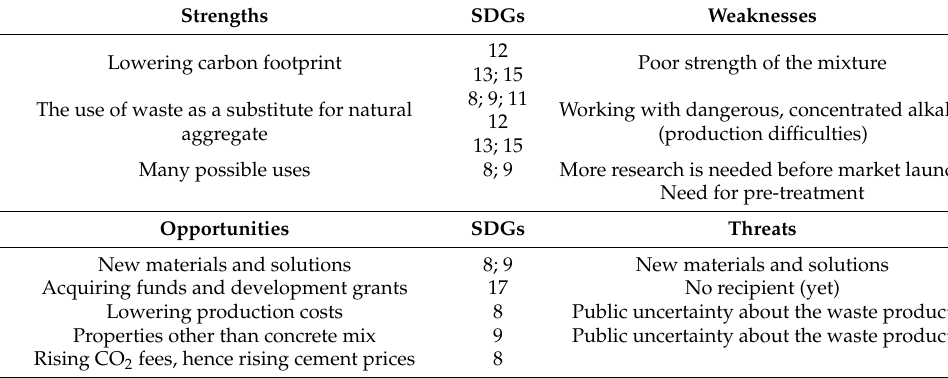
Table 7. SWOT analysis of MSWIBA in geopolymerisation with